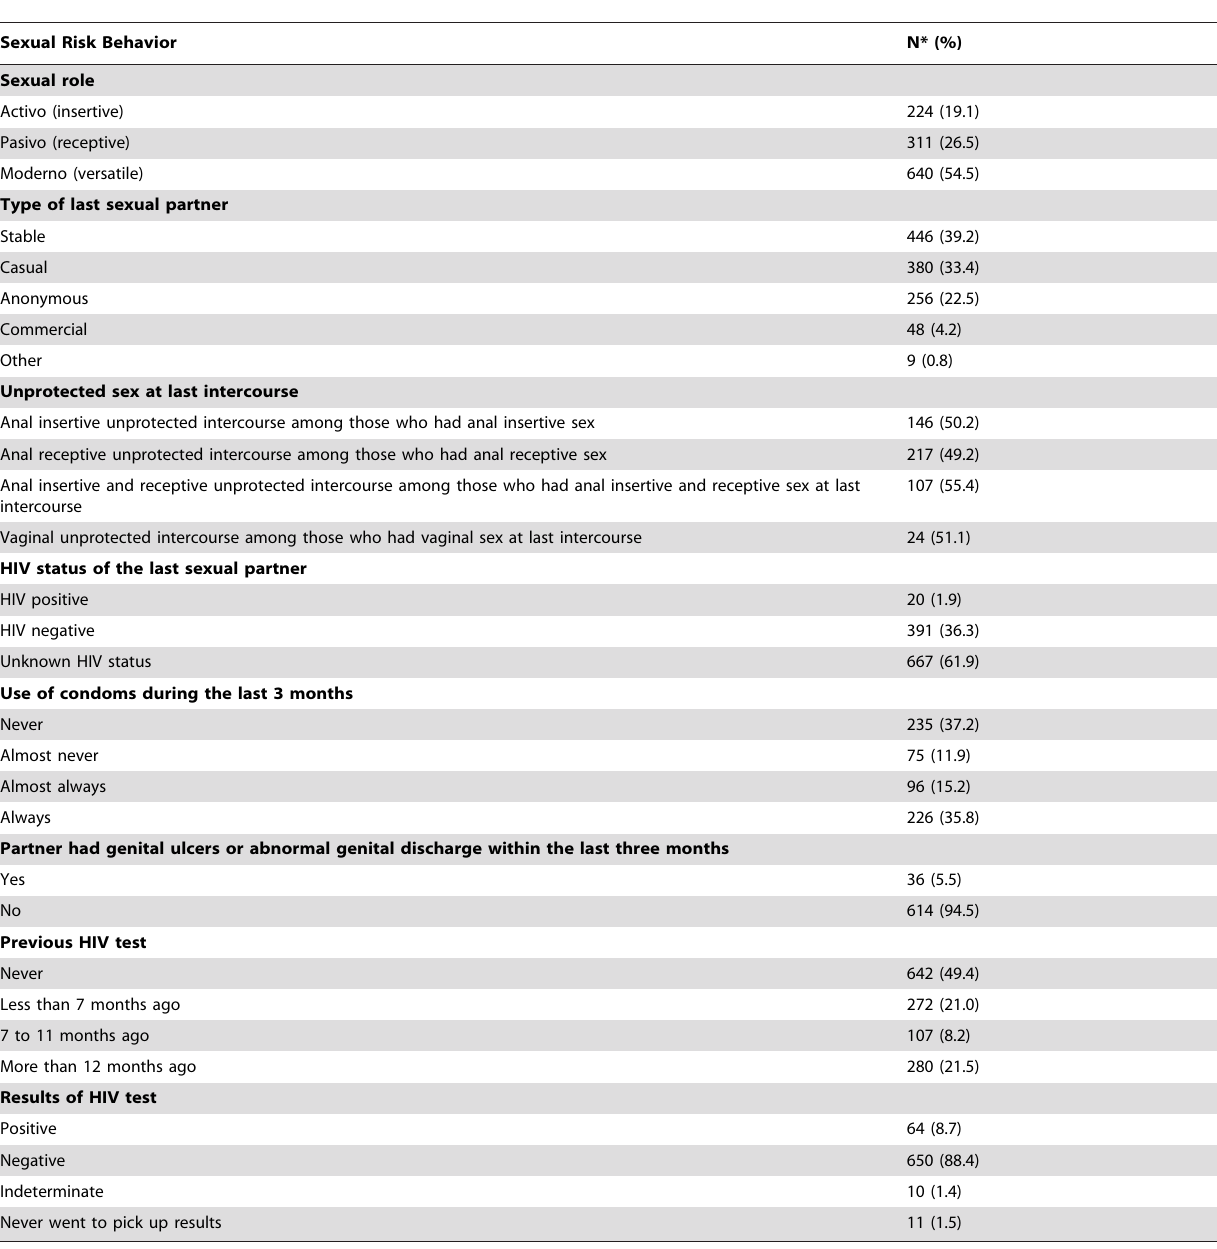
Table 2. Sexual and non-sexual risk behaviors for HIV/STI among MSM who answered an online survey in Peru (N=1301).